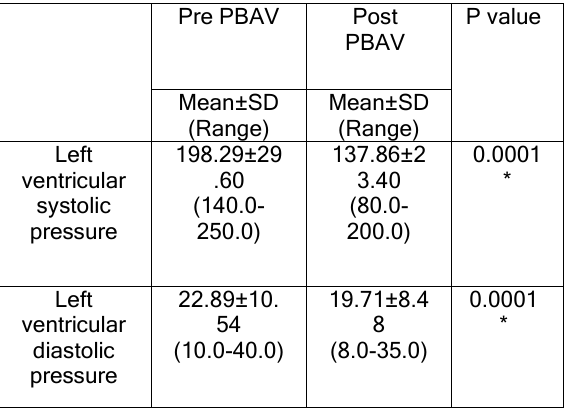
Table (3) : Left ventricular systolic and diastolic pressure assessed by cardiac catheterization pre and post PBAV Table (4) : The echocardiographic data of the patients before , 24 hours and on follow up after PBAV